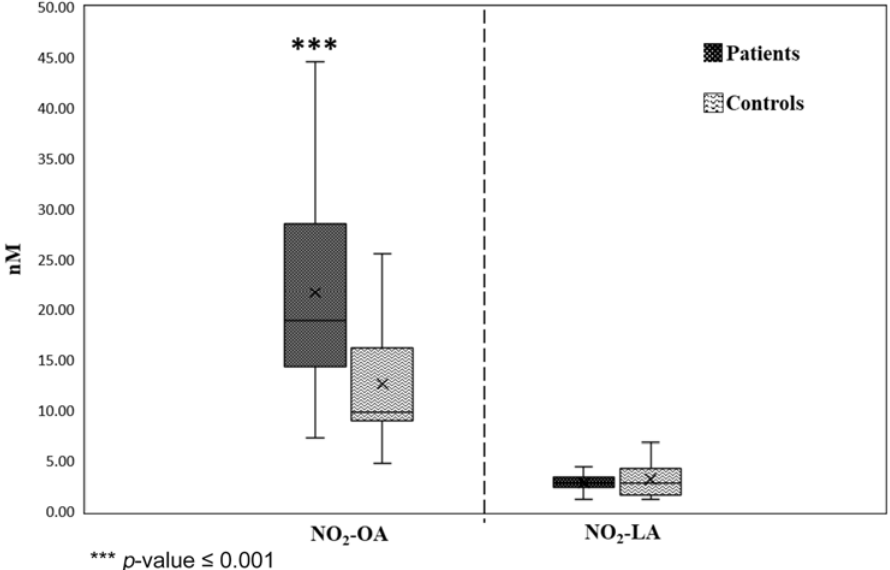
Figure 7. Plasma NO 2 -OA and NO 2 -LA levels in IHD patients and healthy controls. Significant difference is observed in NO 2 -OA levels ( p -value = 0.00071), whereas no significant difference was found in NO 2 -LA levels ( p -value = 0.87288). Within each box, × represents the mean and the horizontal line represents the median.